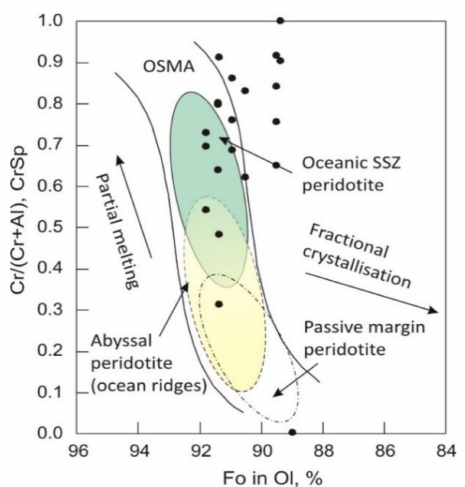
Figure 11. Compositional relationships between Fo content of olivine and Cr# of Cr spinel from the Tog and Shida peridotites. The olivine = spinel mantle array (OSMA) is after [53,54]. Gabbros have leucocratic or melanocatic compositions, according to relative percentages of rock-forming clinopyroxene, olivine, and plagioclase, and enclose thin clinopyroxenite and anorthosite layers and lenses. Olivine and clinopyroxene are early phases; plagioclase is an intercumulus phase in clinopyroxenite but is part of a cumulus assemblage in ophytic gabbro and leucogabbro. The